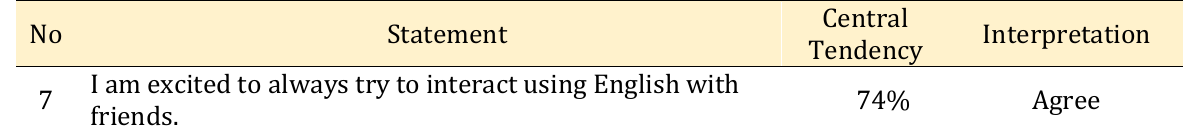
Table 7. Statements 7 questionnaire and interview data